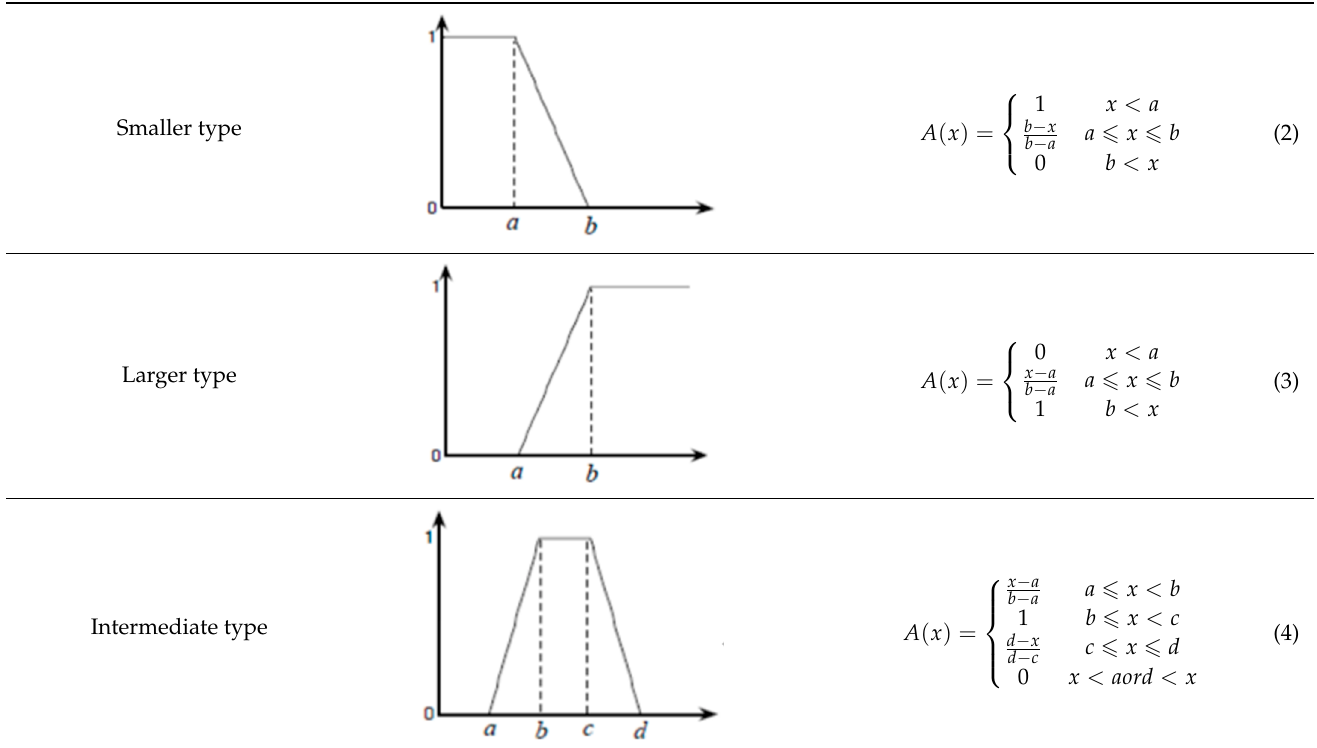
Table 6. Trapezoidal membership function expression.